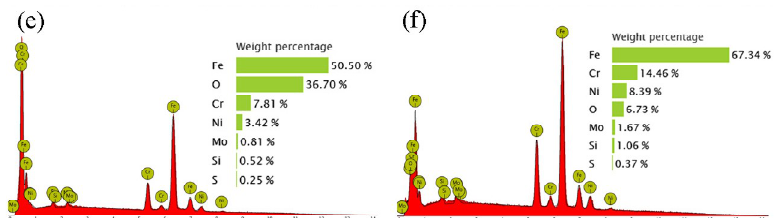
Figure 7. SEM images of the typical worn surfaces of the as-received sample at 200 rpm ( a , b ) and 400 rpm ( c , d ). The right-hand graph is an enlargement of the left-hand graph. The result of EDS analysis ( e , f ), obtained from the region marked by 1 and 2 in ( b ).